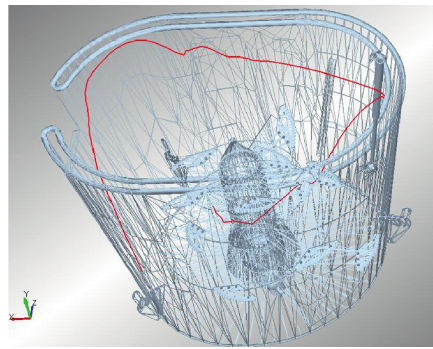
Figure 14: Path of a given